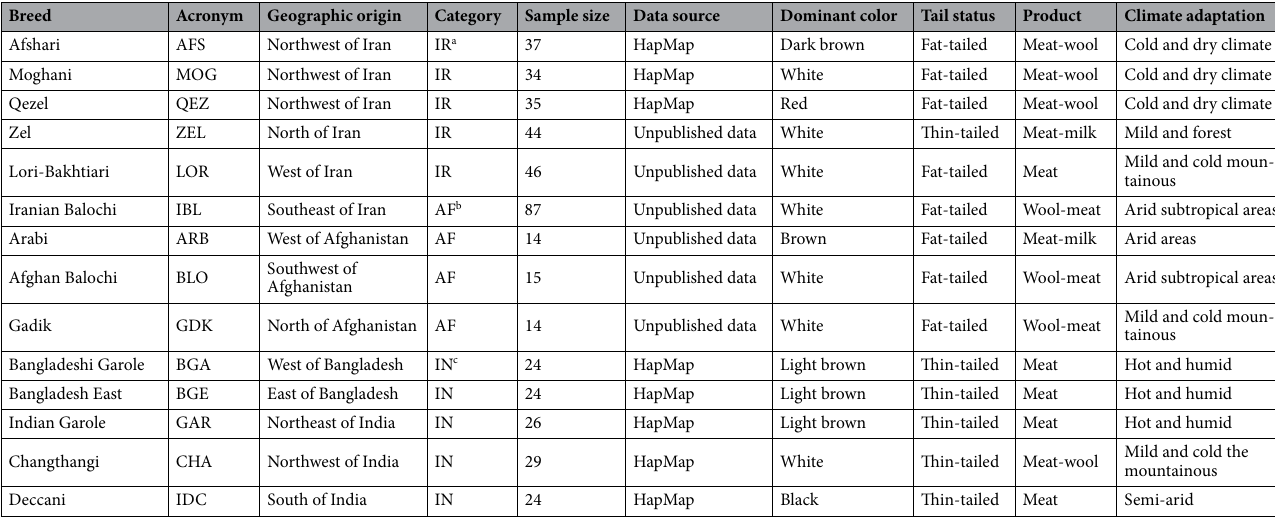
Table 1. Breed names and the corresponding code used throughout the manuscript, the country of origin, sample size, and data source. a Contain Iranian sheep breeds exception Iranian Balouchi. b Contain Afghan sheep breeds and Iranian Balouchi. c Contain Indian and Bengal sheep